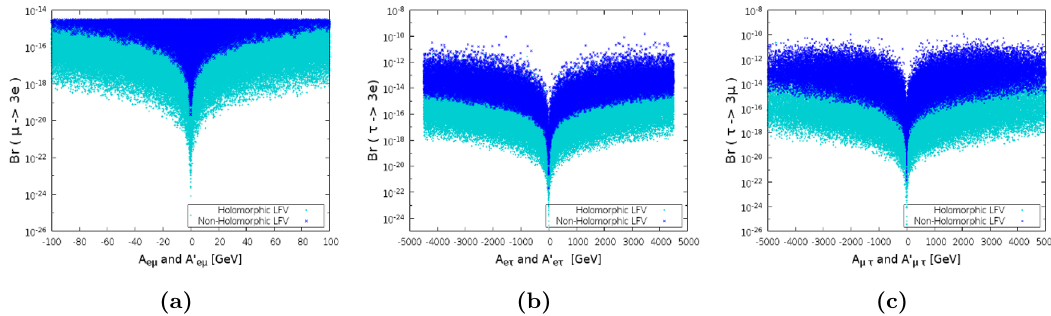
3 e ) with A e(cid:22) and A 0 has been shown in 5(a), 5(b) depicts e(cid:22) ! and in 5(c) depicts Br ( (cid:28) 3 (cid:22) ) with A (cid:22)(cid:28) and A 0 . They are passed e(cid:28) (cid:22)(cid:28) !